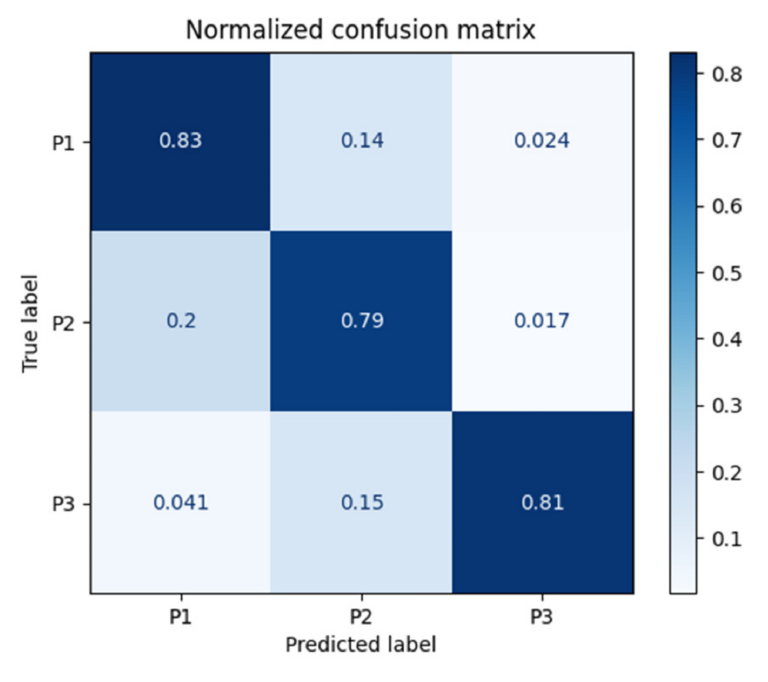
Figure 7. Normalized confusion matrix for ANN.